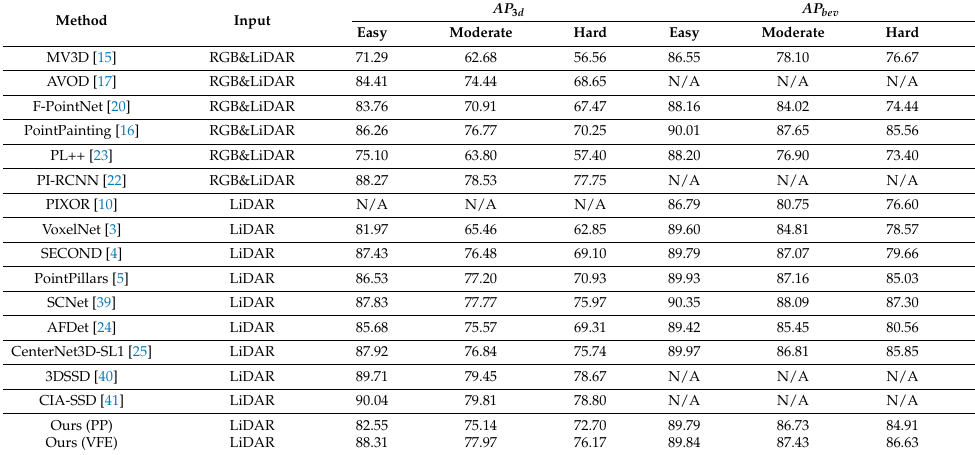
Table 2. Performance comparison with state-of-the-art methods. We set IoU as 0.7 for AP 3 d and AP bev on KITTI validation set for Car